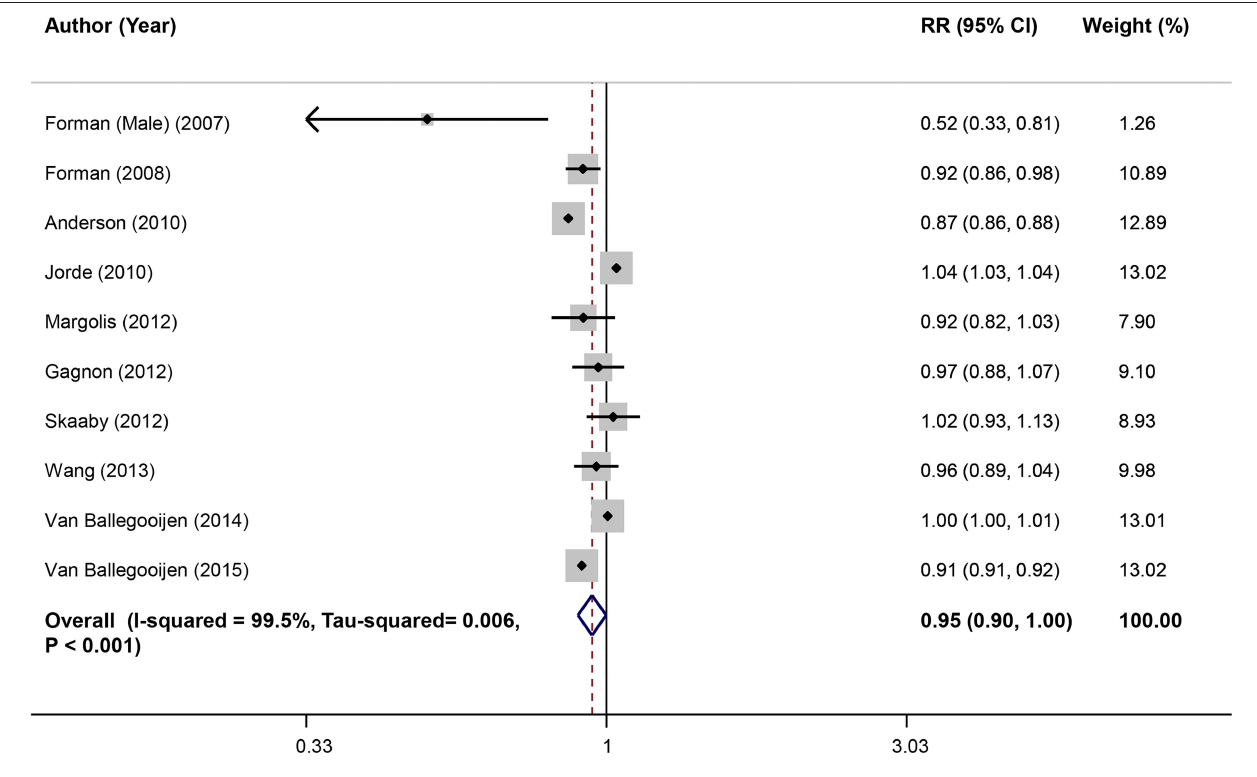
FIGURE 3 | Linear dose–response meta-analysis of serum vitamin D and risk of HTN in prospective studies.